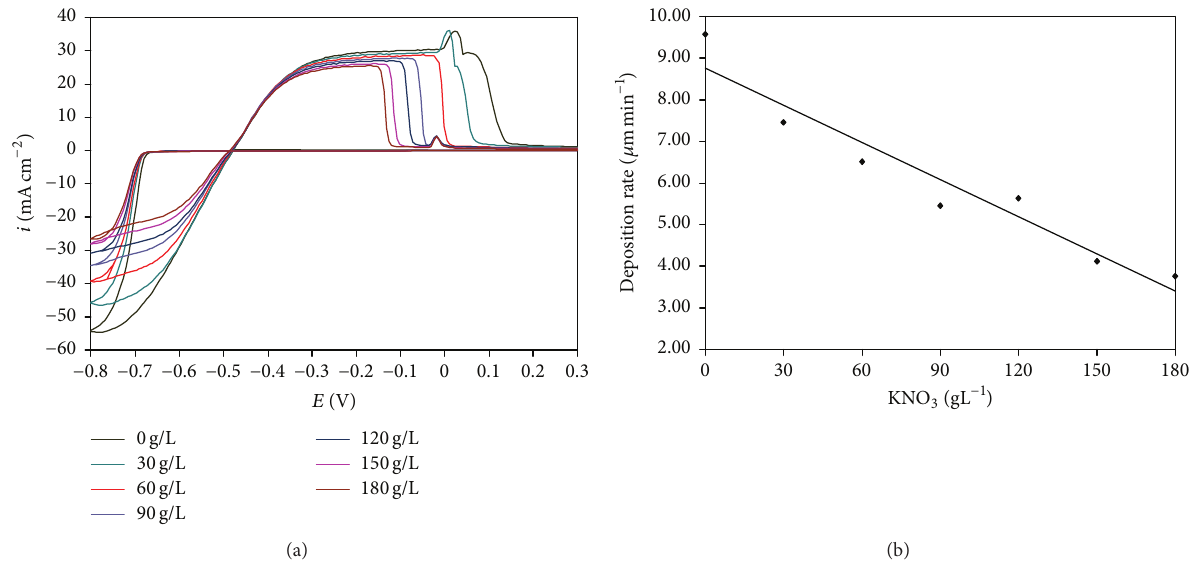
Figure 4: (a) Cyclic voltammograms of silver electrodeposition and silver film dissolution in the silver plating solution consisting of 120g/L KAg(CN) 2 , 6 g/L KCN, and 0–180 g/L KNO 3 . (b) The effect of 0–180 g/L KNO 3 on the deposition rate by sweeping the potential from +0.6 V to − 0.7 V.